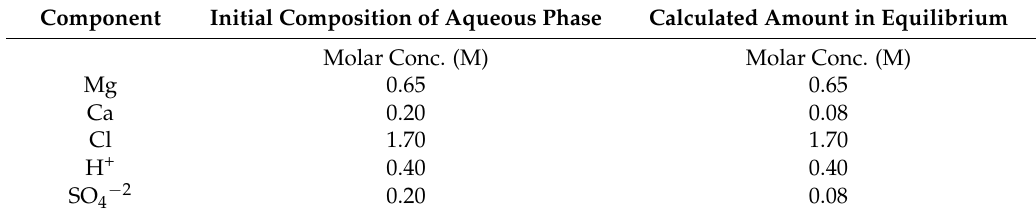
Table 8. Input data and calculated results for gypsum precipitation using V-Minteq software.